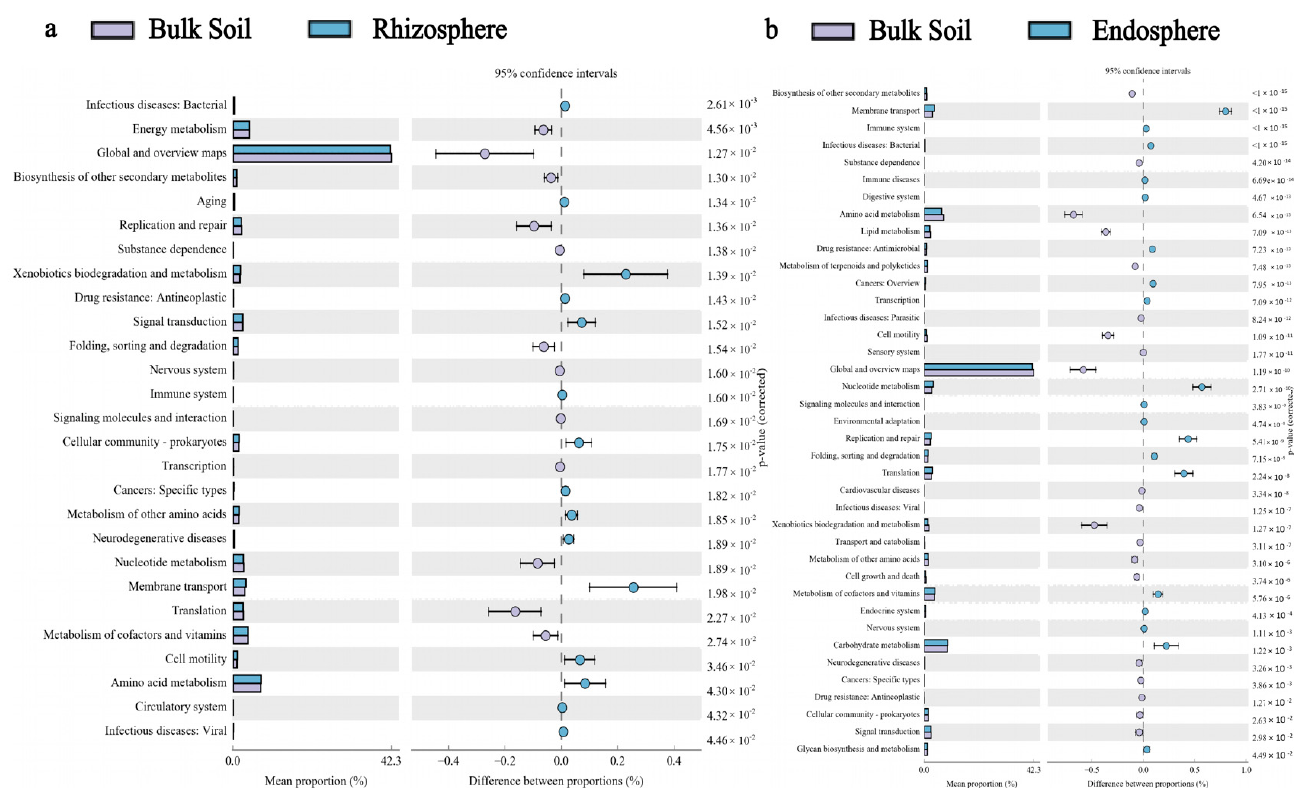
Figure 7. In the second level of the Kyoto Encyclopedia of Genes and Genomes metabolic pathways, with the bulk soil as the control, the differential bacterial functions in the rhizosphere ( a ) and the root endosphere ( b ) were enriched ( p < 0.05).